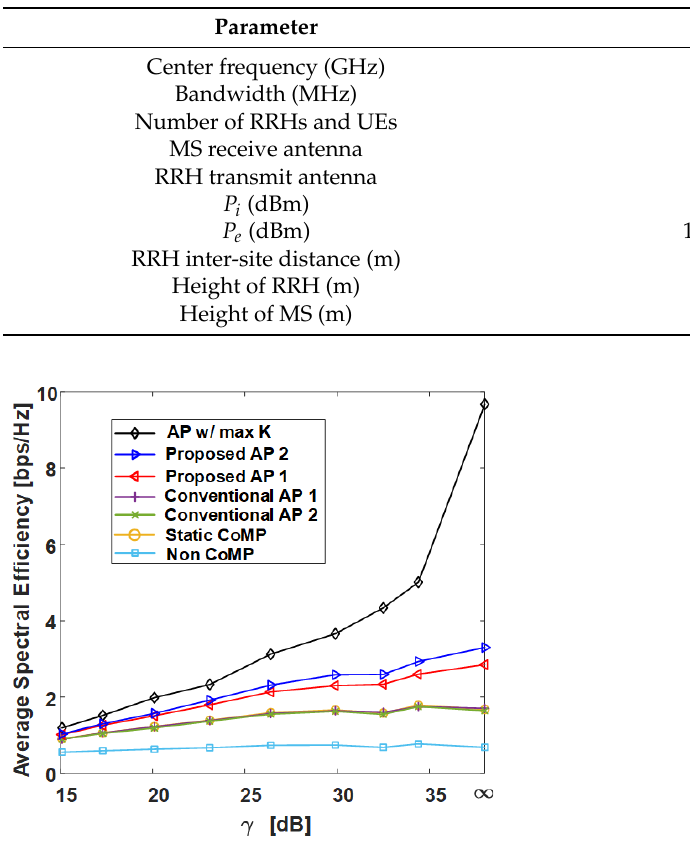
Table 1. Simulation parameter. RRD: Radio remote head.